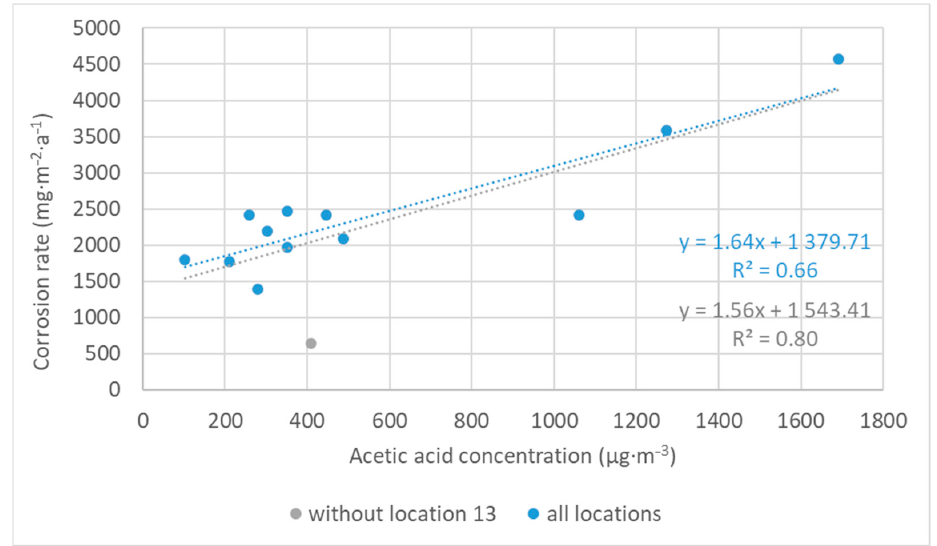
Figure 15. Dependence of corrosion rate of lead based on mass loss on acetic acid content in the air.